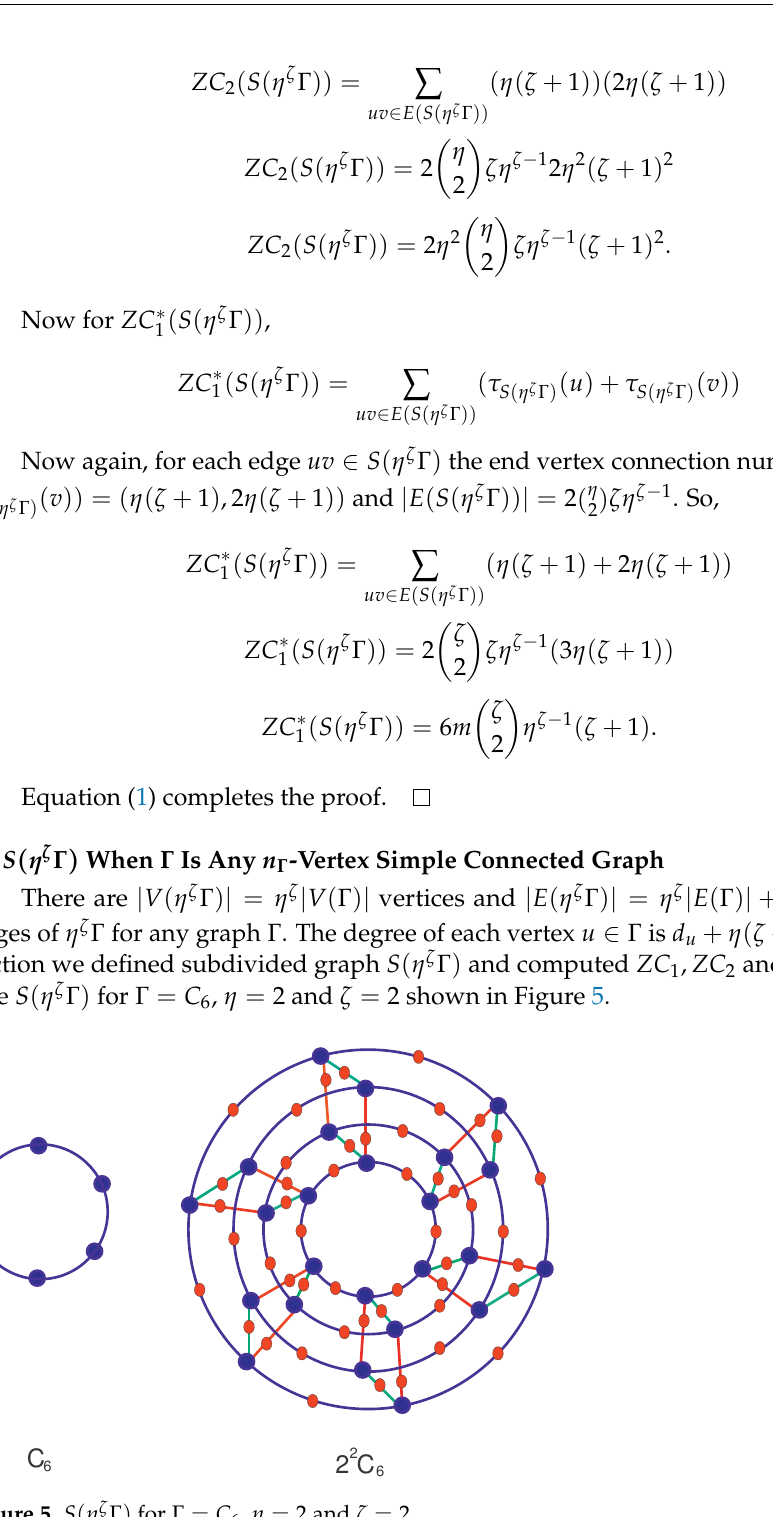
Figure 5. S ( η ζ Γ ) for Γ = C 6 , η = 2 and ζ =